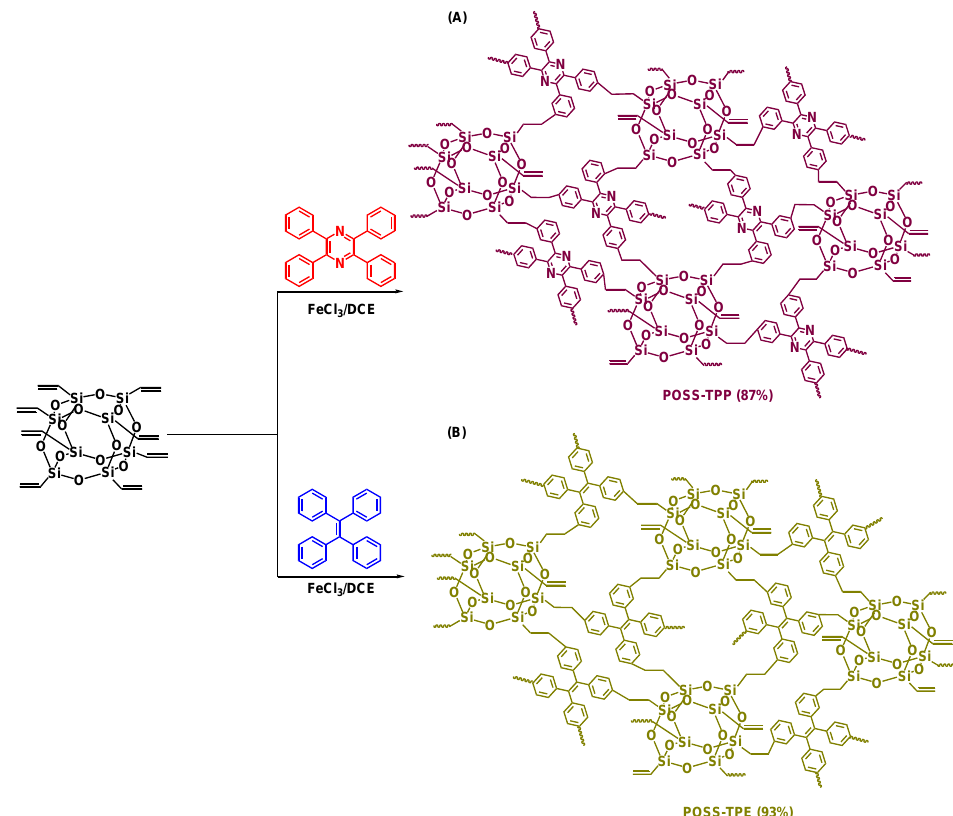
Scheme 2. Synthesis of ( A ) polyhedral oligomeric silsesquioxane tetraphenylpyrazine (POSS-TPP) and ( B ) polyhedral oligo- meric silsesquioxane tetraphenylethene (POSS-TPE).